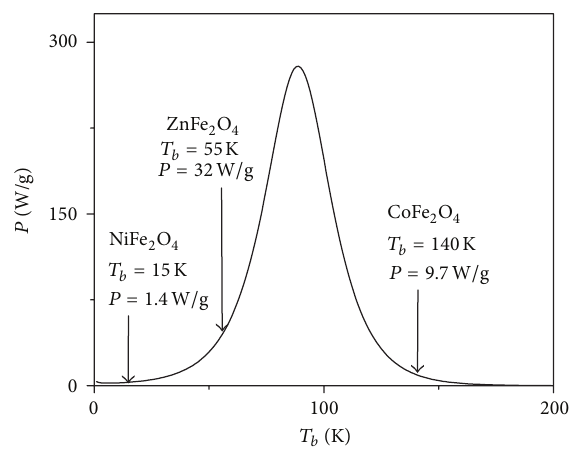
Figure 9: SLP as a function of blocking temperature. The calcula- tions were carried out according to formulae